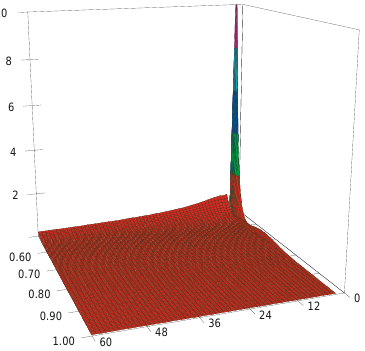
Figure 4. 3D plot of the estimation error for data expressed in logarithm scale as function of p (ranging from 0.500 to 0.999) and n (ranging from 2 to 61).